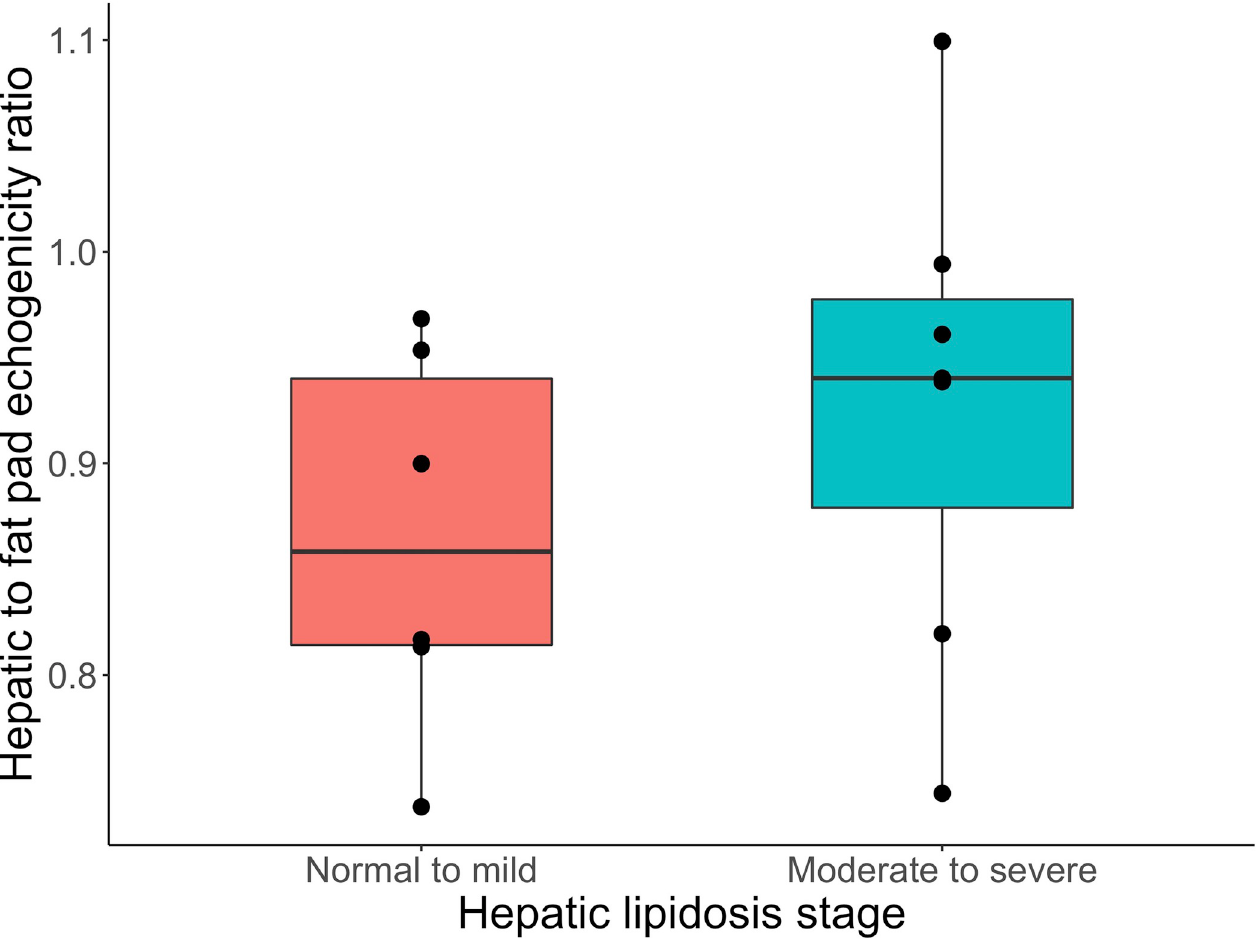
Fig 3. Scatter plot of bearded dragon liver lipid content (%) from histological samples measured by digital analysis as a function of hepatic density (Hounsfield units) measured on computed tomography and analyzed using linear regression. The blue line represents the regression line and the shading the 95% confidence